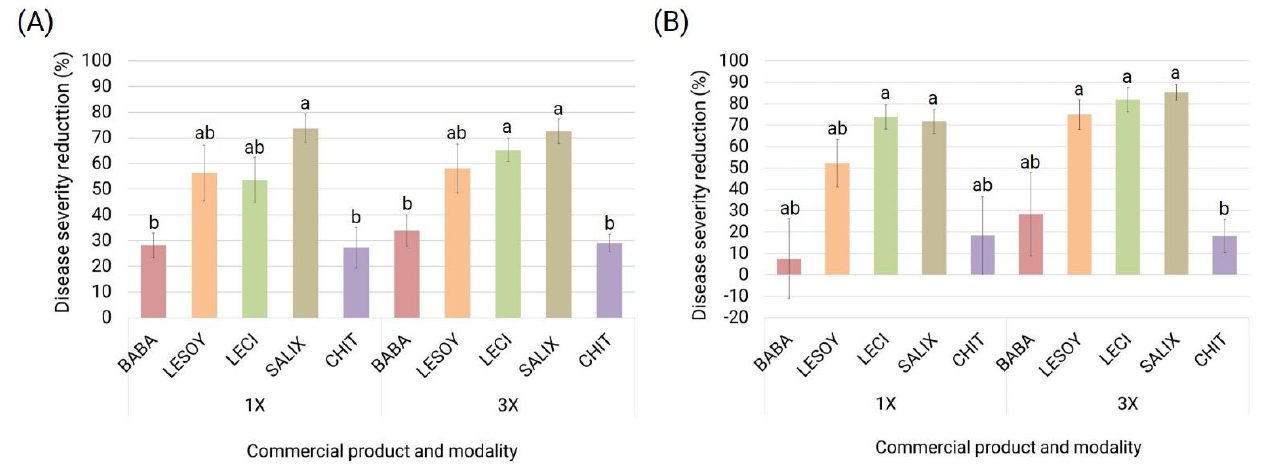
Figure 4. CHIT, LECI, LESOY and SALIX, as the control BABA showed preventive protection against downy mildew at the whole-plant level in ( A ) Vitis vinifera cv. Tempranillo, clone VN-40, and in ( B ) Vitis vinifera cv. Tempranillo, clone RJ-78. A Tukey’s post hoc test ( α = 0.05) was performed for each experiment in order to find statistical differences between products and modalities (1 × and 3 × ). Significant differences between products are denoted by different small letters in the bar graphs.